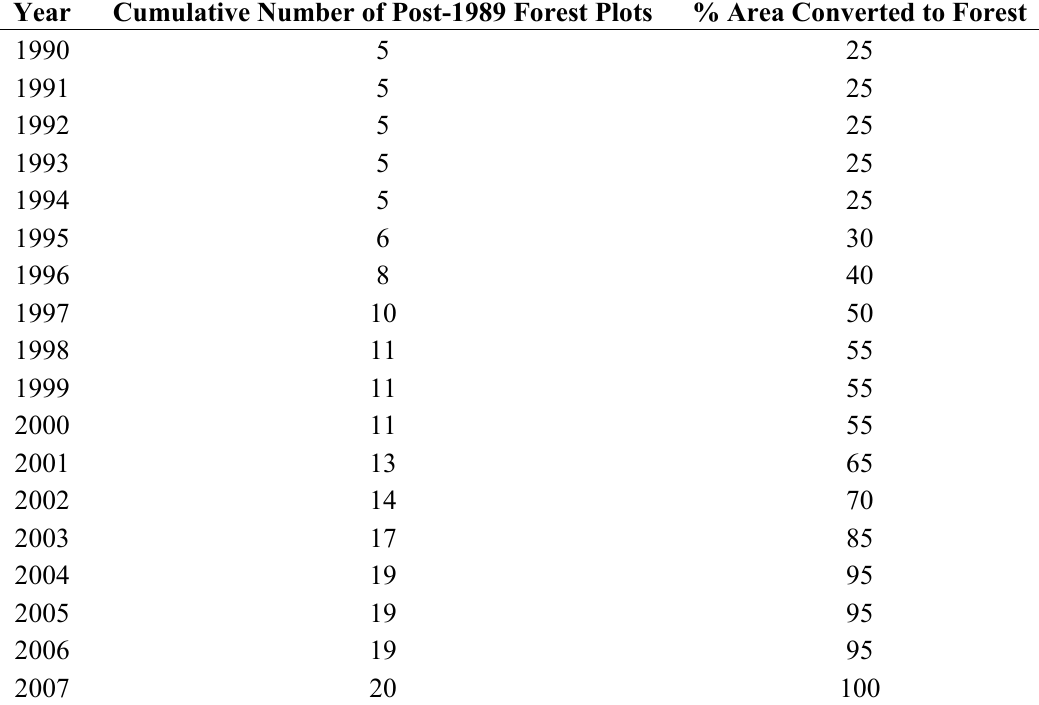
Table 6. Year of conversion of grassland to post-1989 natural forest, based on the threshold method for determining stand age. Shown is the cumulative number of plots converted to post-1989 forest at the end of each calendar year and their cumulative area as a percentage of their total area in